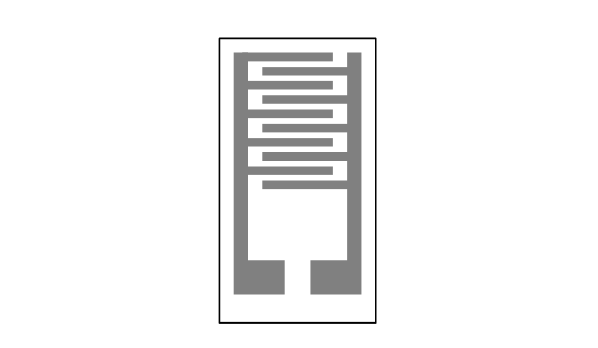
Figure 4. Interdigitated electrodes. The dark pattern is conducting electrode and the white part is insulating substrate.